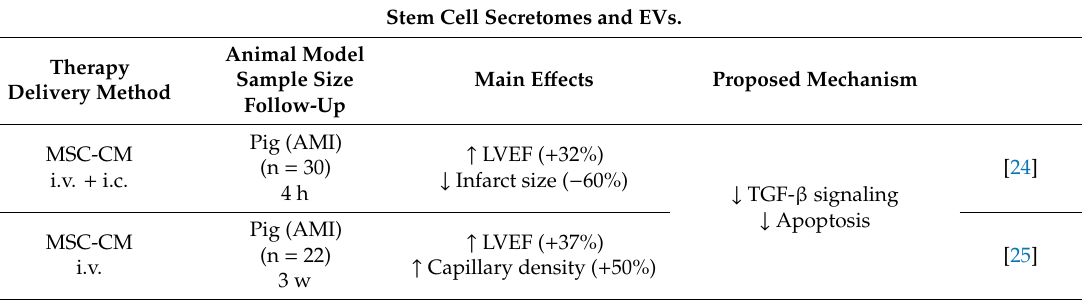
Table 1. Stem cell secretomes and extracellular vesicles (EVs). Stem Cell Secretomes and